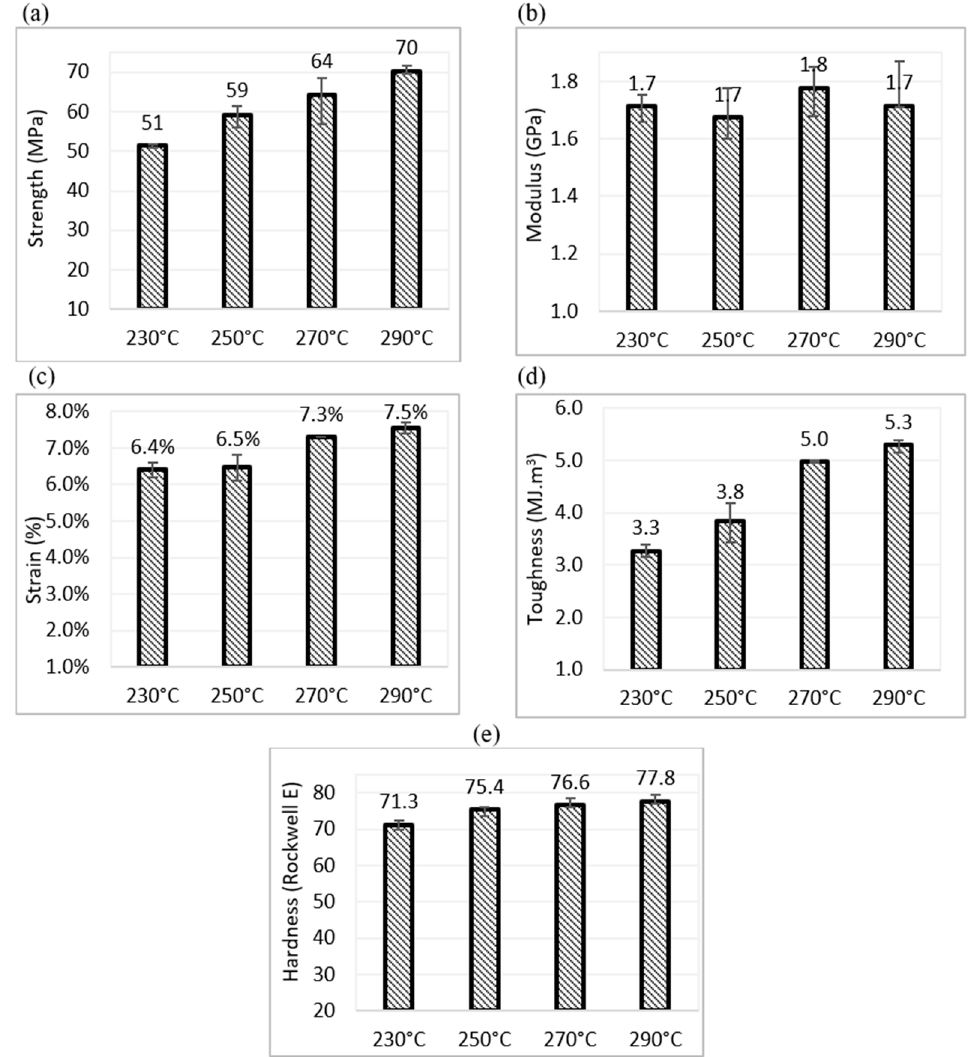
Figure 9. Tensile properties of semi-crystalline CF-PA composites at different printing temperatures: ( a ) ultimate tensile strength, ( b ) modulus, ( c ) ductility, ( d ) toughness, ( e ) hardness .